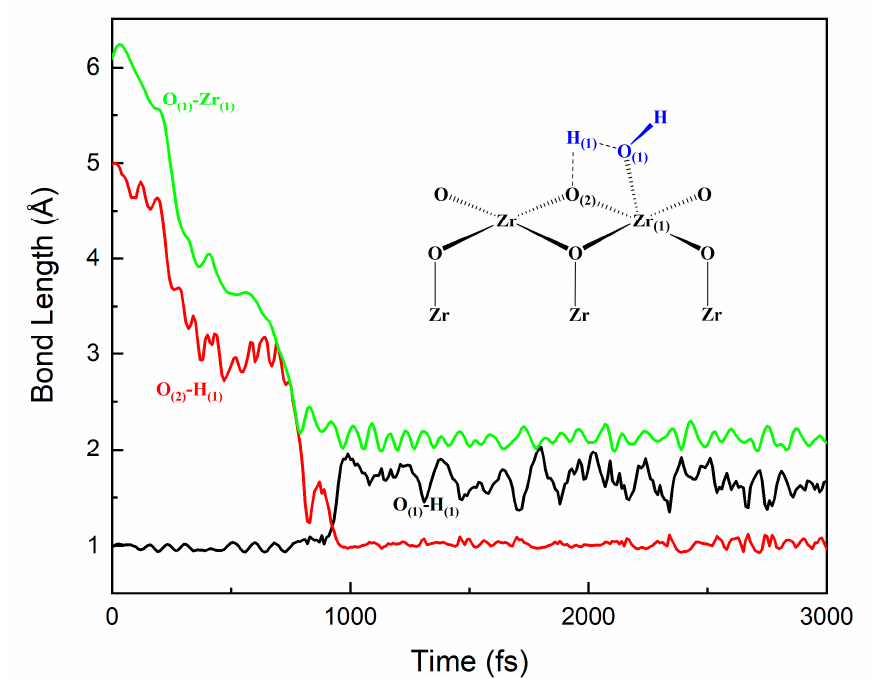
Figure 7. Evolutions of O–H and Zr–O bonds of the interface reaction between the first layer of water and the ZrO 2 surface at site A .